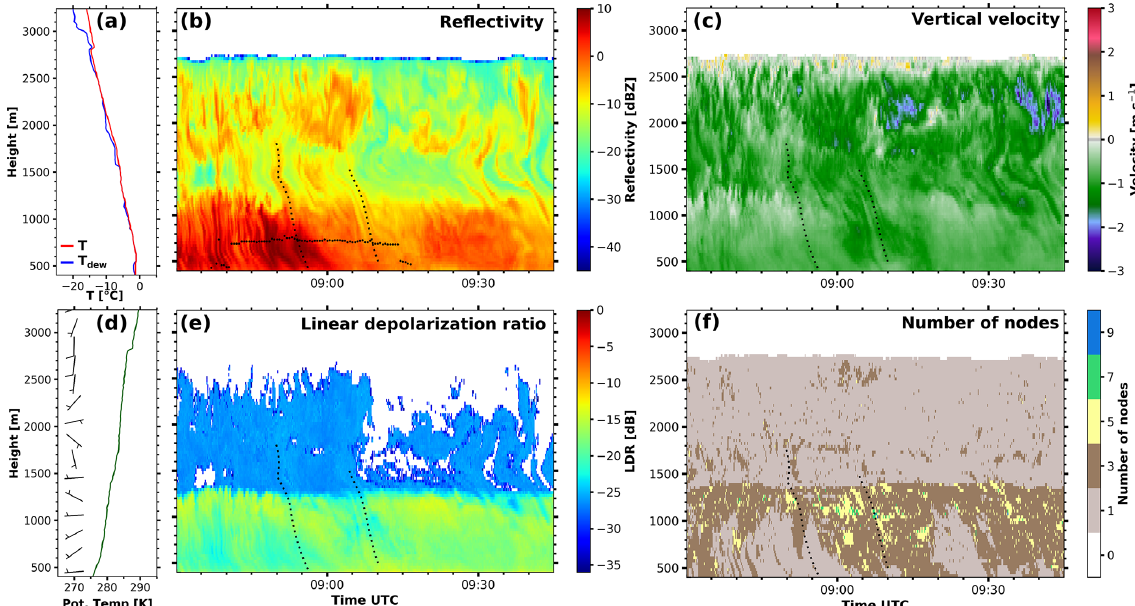
Figure 6. Radiosonde ascend on 29 June 2017 at 10:50UTC ( a , d from Schmithüsen, 2017). MIRA-35 reflectivity with lidar-detected cloud- base height (black dots, b ), mean velocity (c) and linear depolarization ratio (e) of the zeroth node (moments of the single-peak analysis) on 29 June 2017 from 08:30 to 09:45UTC. Total number of nodes (f) for the same